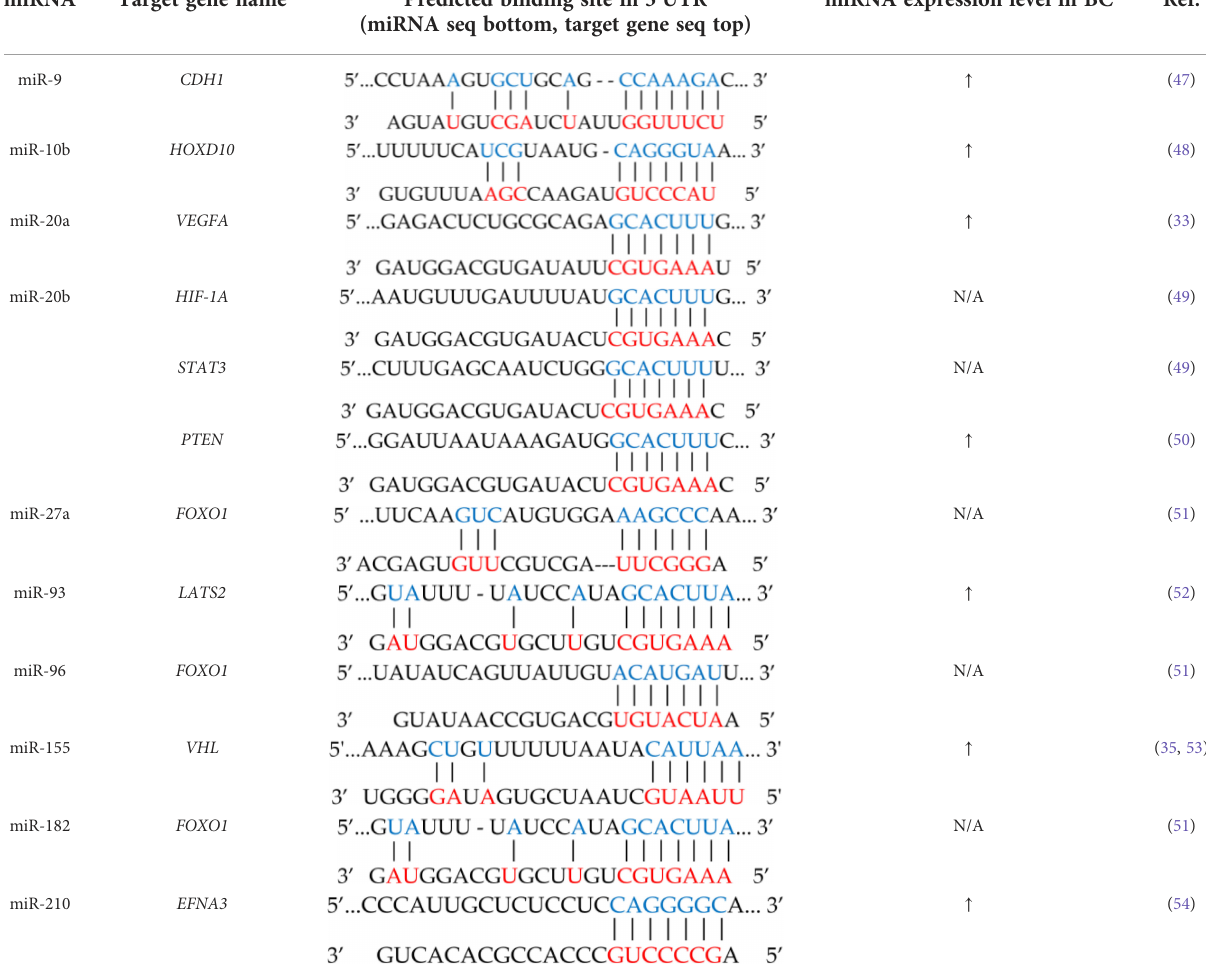
TABLE 1 Pro-angiogenic miRNAs in breast cancer and their target genes.